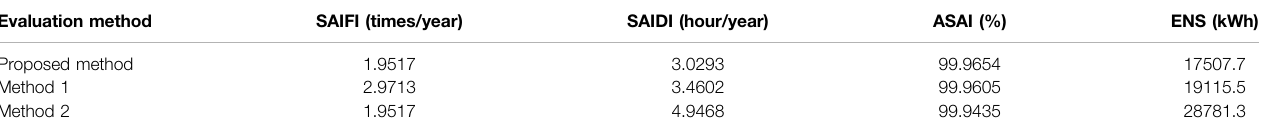
TABLE 6 | System reliability indicators of the three methods.